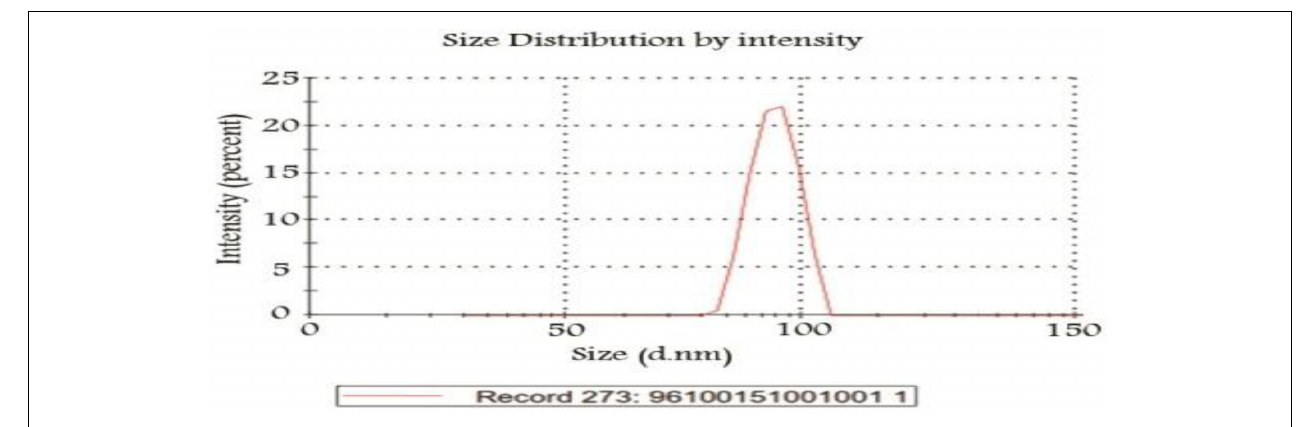
FIGURE 4 | GPC image of nanopolymer.